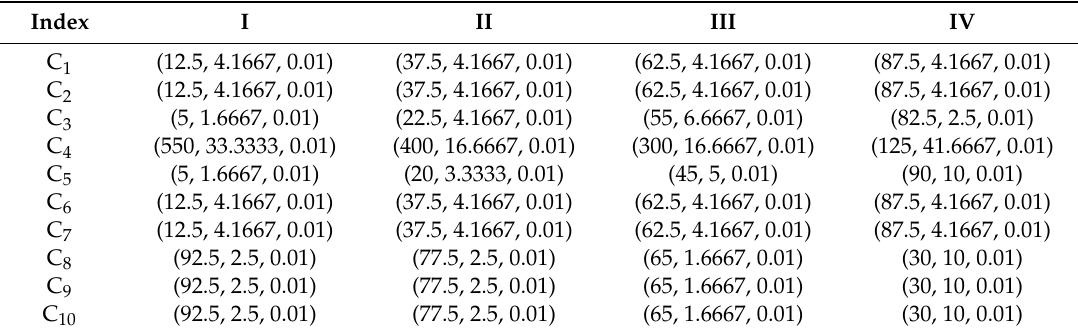
Table 6. Cloud numerical characteristics ( E x , E n , H e ) of each assessment